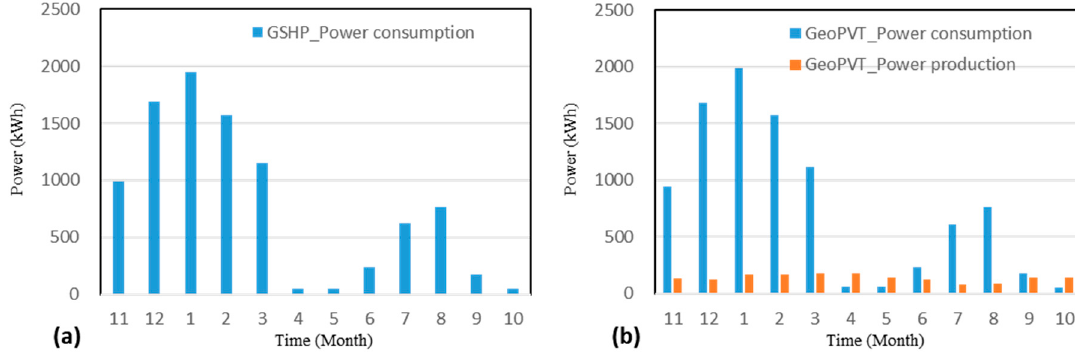
Figure 40. Power consumption and production of system in 231 m 2 . ( a ) GSHP; ( b ) Geo-PVT.